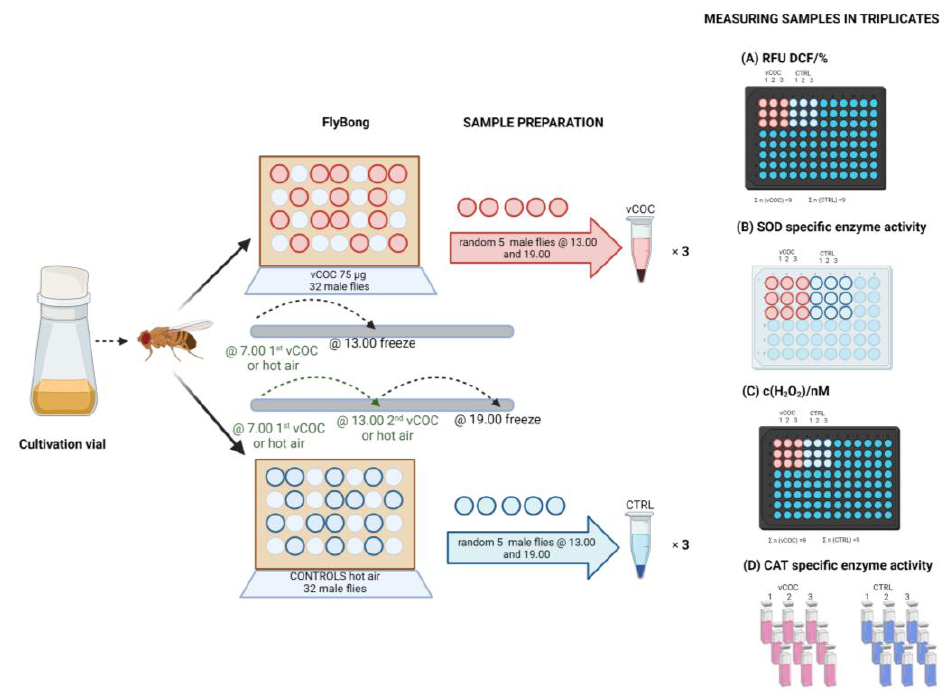
Figure 1. Whole body sample preparation and biochemical measurement flowchart. wt males were exposed to hot air (control) or vCOC using the FlyBong (described in the Section 2.3.). Here only a front cross-section of the vertical DAMS with single IR beam is presented. After single or double vCOC administration control and experimental samples were collected and prepared for the measurement of: ( A ) total ROS using fluorescent redox sensitive dye 2′,7′ -dichlorofluorescein (DCF) expressed as percent of 2′,7′ -dichlorofluorescein (DCF) relative fluorescence units (RFU), ( B ) superoxide dismutase (SOD) specific enzyme activity as % of quercetin oxidation inhibition in the presence of N,N,N′,N ′ -tetramethylethylenediamine (TEMED), ( C ) hydrogen peroxide (H 2 O 2 ) concentration using calibration curve for dihydroethidium (DHE) and ( D ) catalase (CAT) specific enzyme activity as time depended decline in H 2 O 2 concentration.